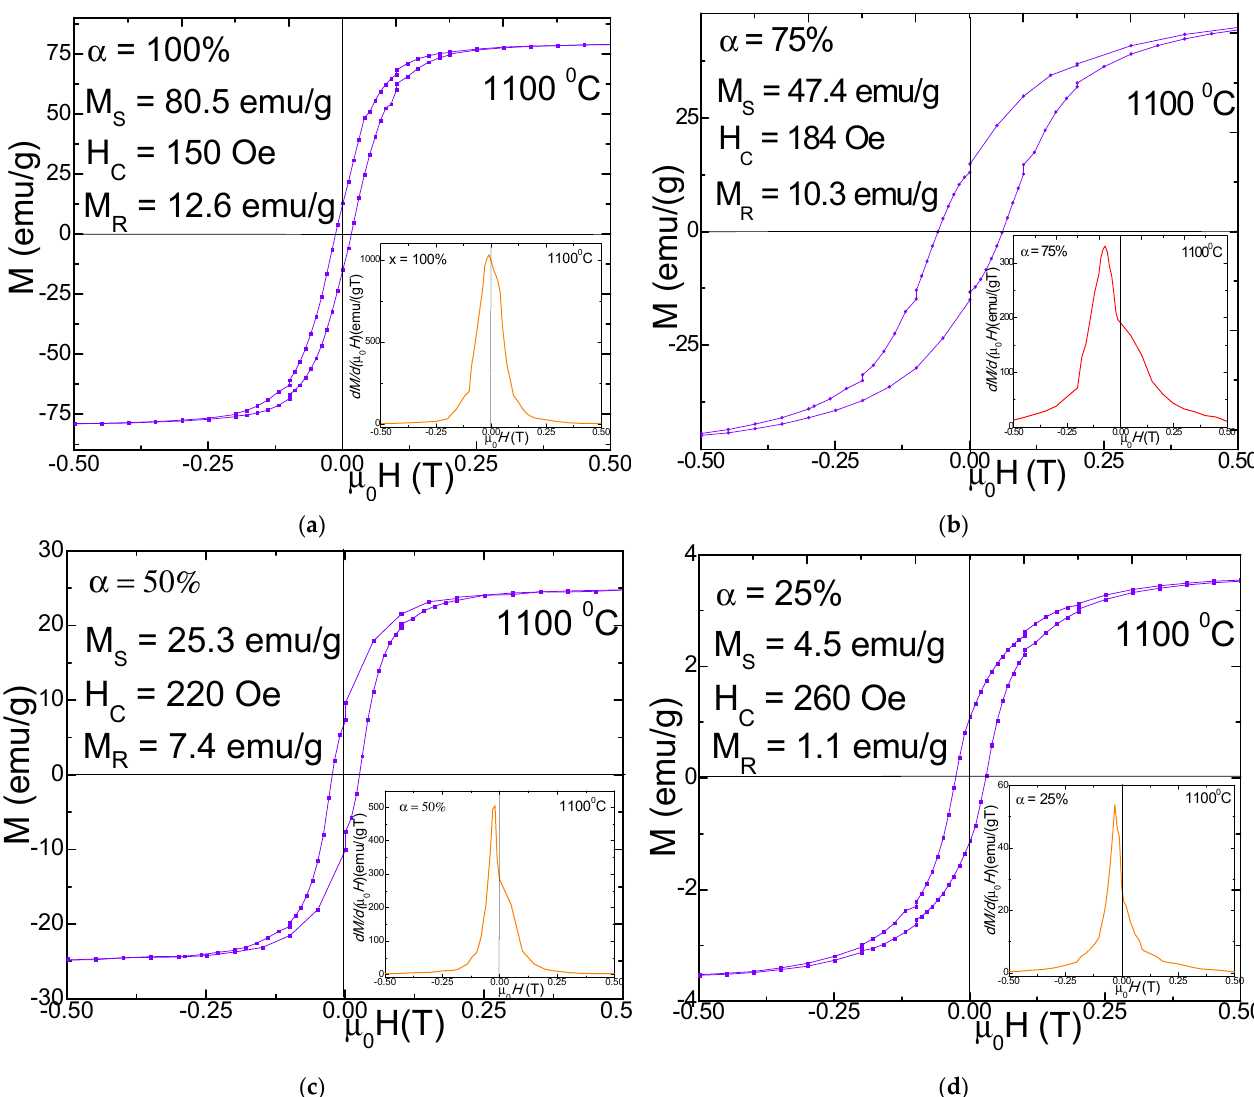
Figure 5. Magnetic hysteresis loop and magnetization derivative of (N i0 . 6 Mn 0 . 4 Fe 2 O 4 ) α (SiO 2 ) 100 −α ( α = 100% ( a ), 75% ( b ), 50% ( c ) and 25% ( d )) NCs calcined at 1100 °C.